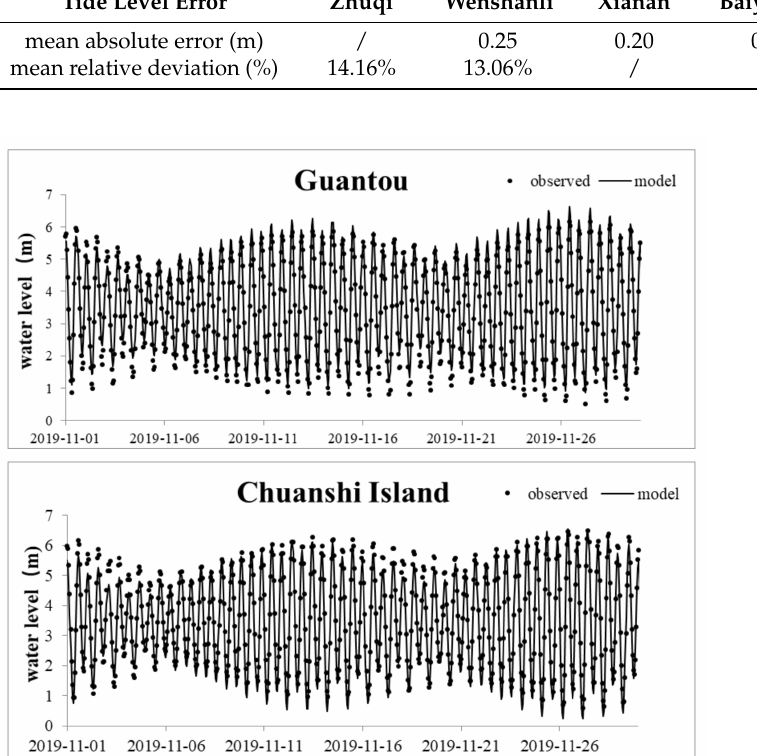
Figure 3. Tide level calibration results for Guantou and